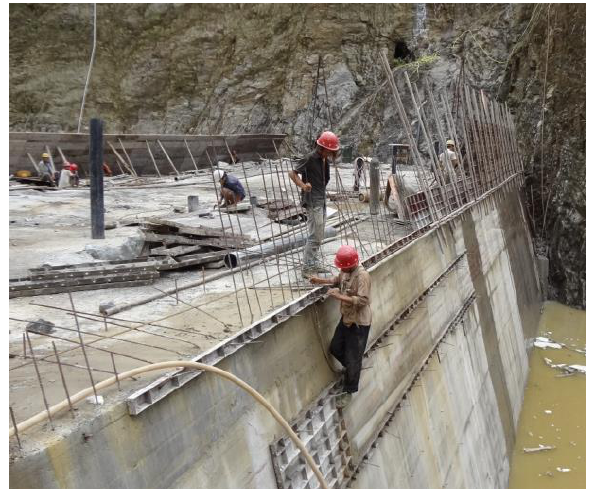
Figure 3. Flow chart of RFC construction.